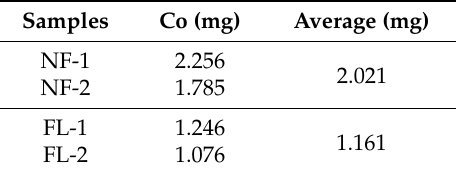
Table 2. The element mass fraction of CoO-NFs and CoO-FLs.